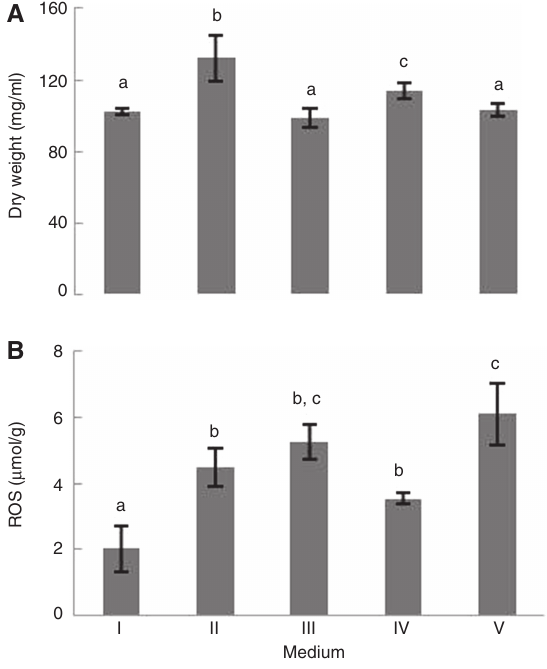
Figure 1: (A) Wet weight and (B) ROS content of Saccharomyces cerevisiae UE-ME grown in I- YEPG medium, II- YEPGD medium, 3 III- YEPGD medium and 5 μ g/ml TiO -NP add at 100 min, IV-YEPGD 2 medium with heat shock (28/40 ° C) at 100 min,V-YEPGD medium and 5 μ g/ml TiO -NP with heat shock (28/40 ° C) at 100 min. The results 2 represent the mean of five independent experiments ± standard error of mean. The bars marked with different letters (a-c) are signifi- cantly different, in accordance with the Duncan test (p <